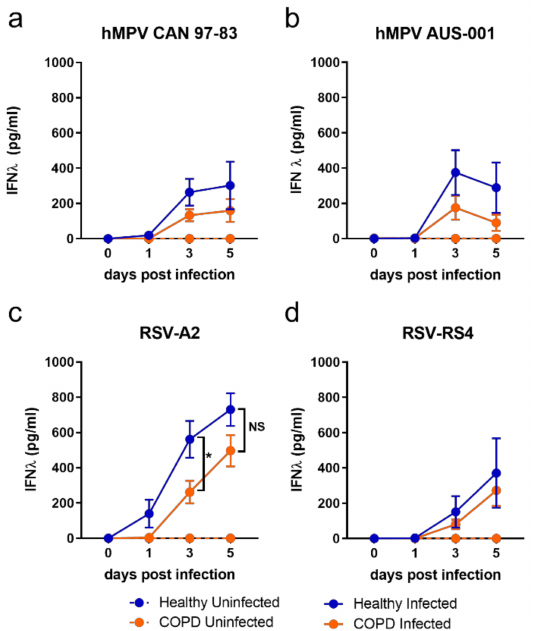
Figure 2. IFN- λ production by submerged monolayers of BECs infected with ( a ) CAN 97–83 ( b ) AUS- 001 ( c ) A2 or ( d ) RS4, MOI 0.1. Secreted IFN- λ was quantified in cell supernatant at day 0, 1, 3, and 5 post-infection by ELISA. The symbols represent the mean ± SEM. n = 5 for both COPD and healthy groups. Unpaired t -tests show statistical significance, * denotes p < 0.05 for COPD group compared to the healthy